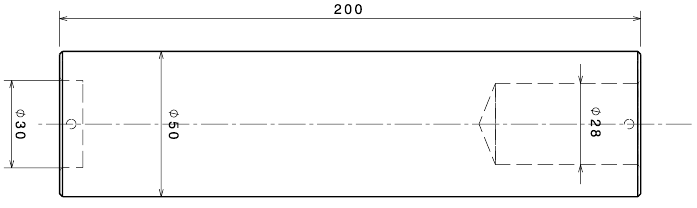
Figure 9. Geometry of the target support for all experiments.